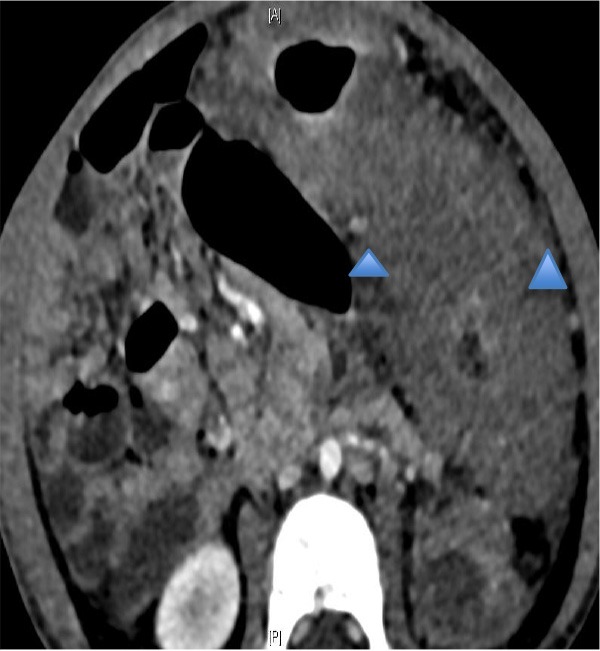
Same as Figure 3.